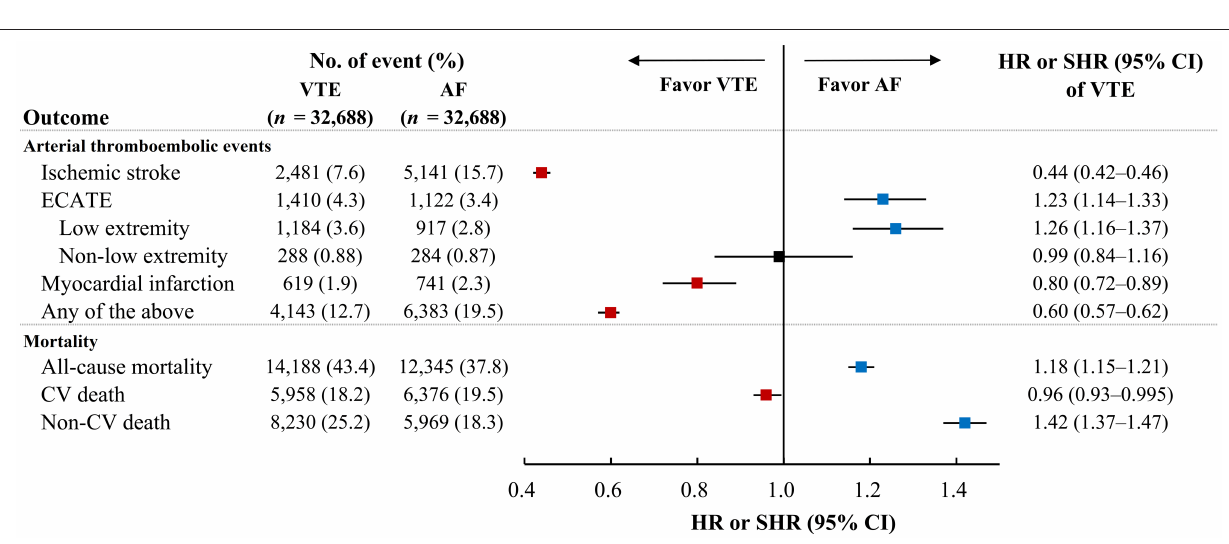
FIGURE 4 | The incidence of arterial thromboembolic events and mortality between VTE and AF cohorts. The incidence of ischemic stroke and myocardial infarction were lower in VTE cohort than AF cohort but ECATE, particularly in low extremity, was lower in AF cohort than VTE cohort. In terms of mortality, CV death was lower in VTE cohorts than AF cohort while all-cause mortality and non-CV death were lower in AF cohort than VTE cohort. AF, atrial fibrillation; CV, cardiovascular; ECATE, extracranial arterial thromboembolic event; VTE, venous thromboembolism. VTE, despite having risk factors in common. The VTE cohort had higher risks of all-cause mortality and ECATE, particularly lower extremity events, compared to AF